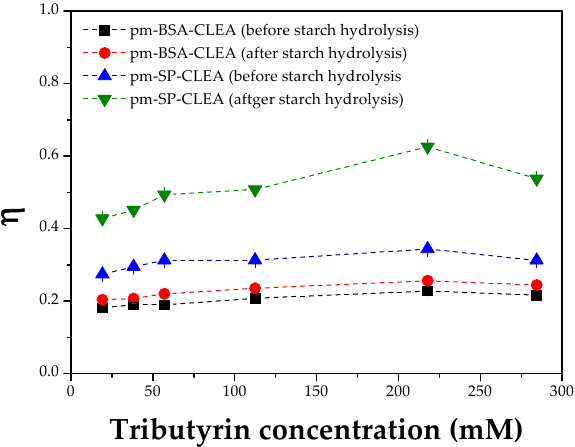
Figure 10. Effectiveness factors ( η ) for CLEAs of PPL. Biocatalyst preparation conditions: treatment of PPL surface with dodecyl aldehyde (PPL/dodecyl aldehyde mass ratio of 1:1), aggregation/precipitation with ethanol (enzyme solution/ethanol volume ratio of 1:3) in presence of LPP/BSA/SMNPs or LPP/SP/SMMPs mass ratio of 1:1.5:1.5 and starch (0.8% w / v ) for 0.5 h, followed by treatment with glutaraldehyde (5 μ moles of glutaraldehyde/mg total protein) for 15 h at 4 °C under 150 rpm. Starch was washed away by hydrolysis with α -amylase at 25 °C for 2 h under 150 rpm stirring. Activity assay conditions: hydrolysis of tributyrin solutions (19.28, 38.35, 57.2, 112.5, 217.9 and 284.4 mM) at 40 °C and pH 8.0 for 5 min under 500 rpm stirring.